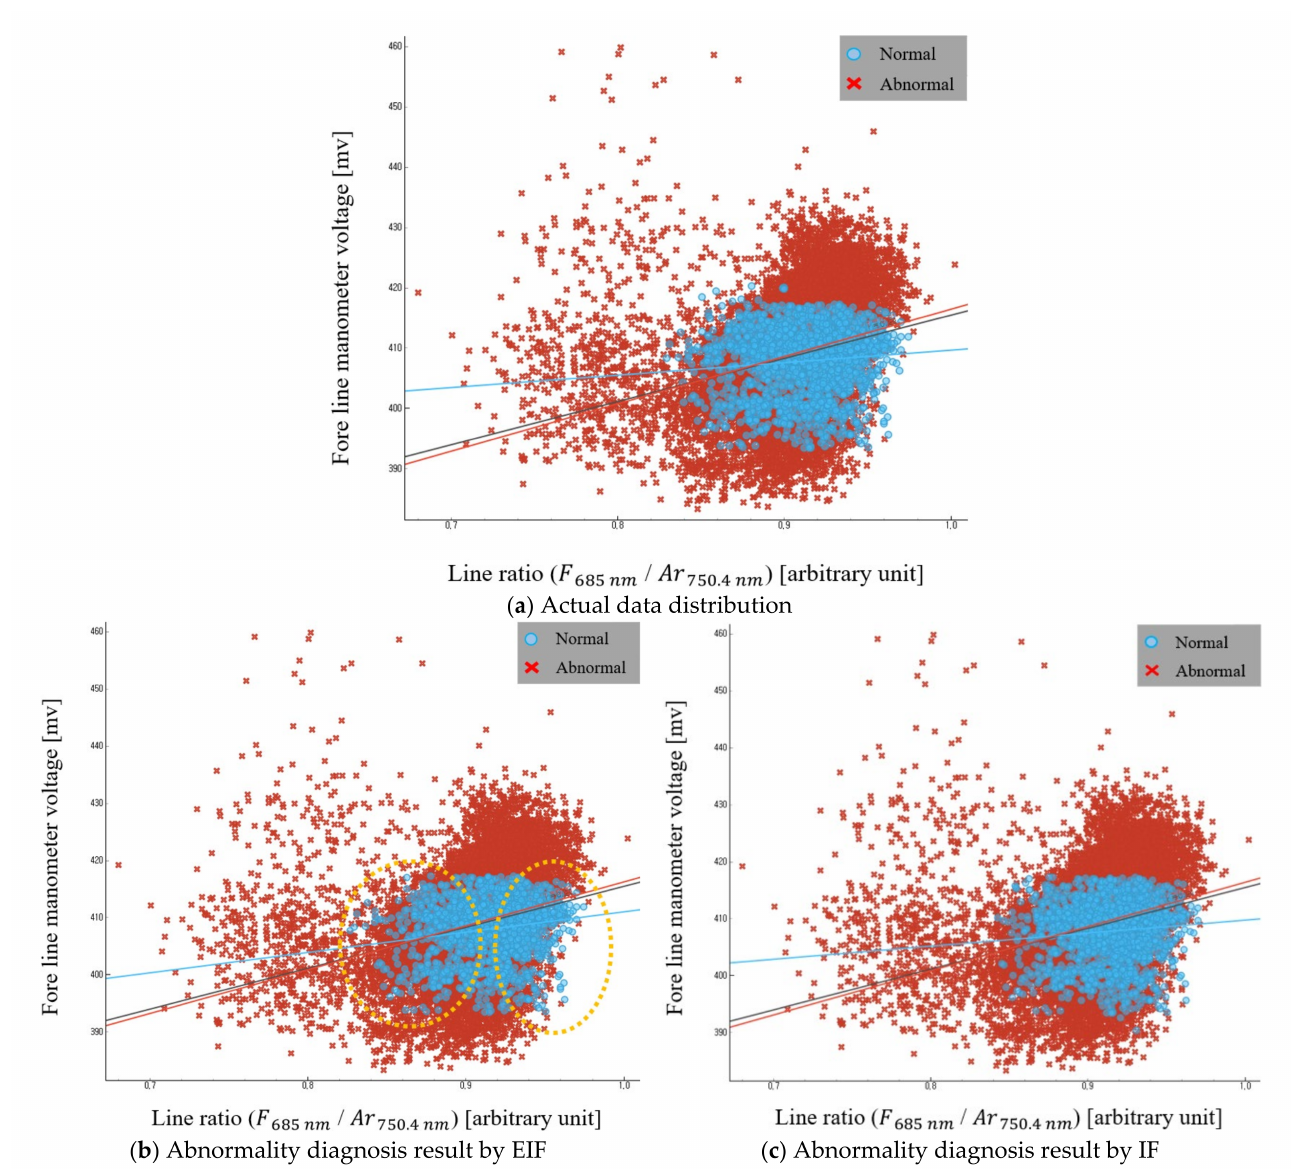
Figure 7. ( a ) Actual data distribution of the fore line manometer voltage versus line ratio (F 685nm /Ar 750.4 nm ) as a scatter plot; Abnormality diagnosis result by ( b ) EIF ( c )